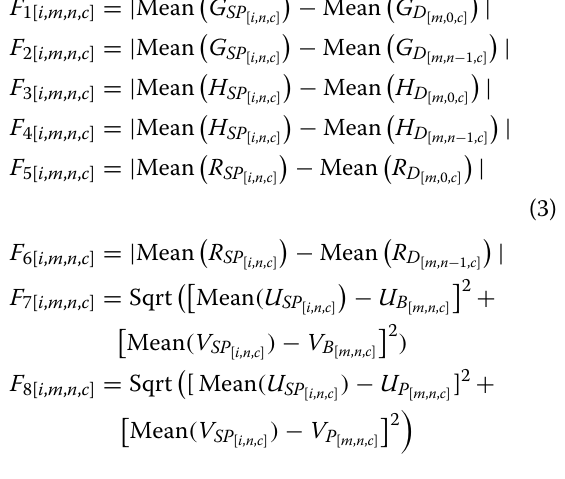
number n in camera c . F 1[ i , m , n ] to F 8[ i , m , n , c ] are the